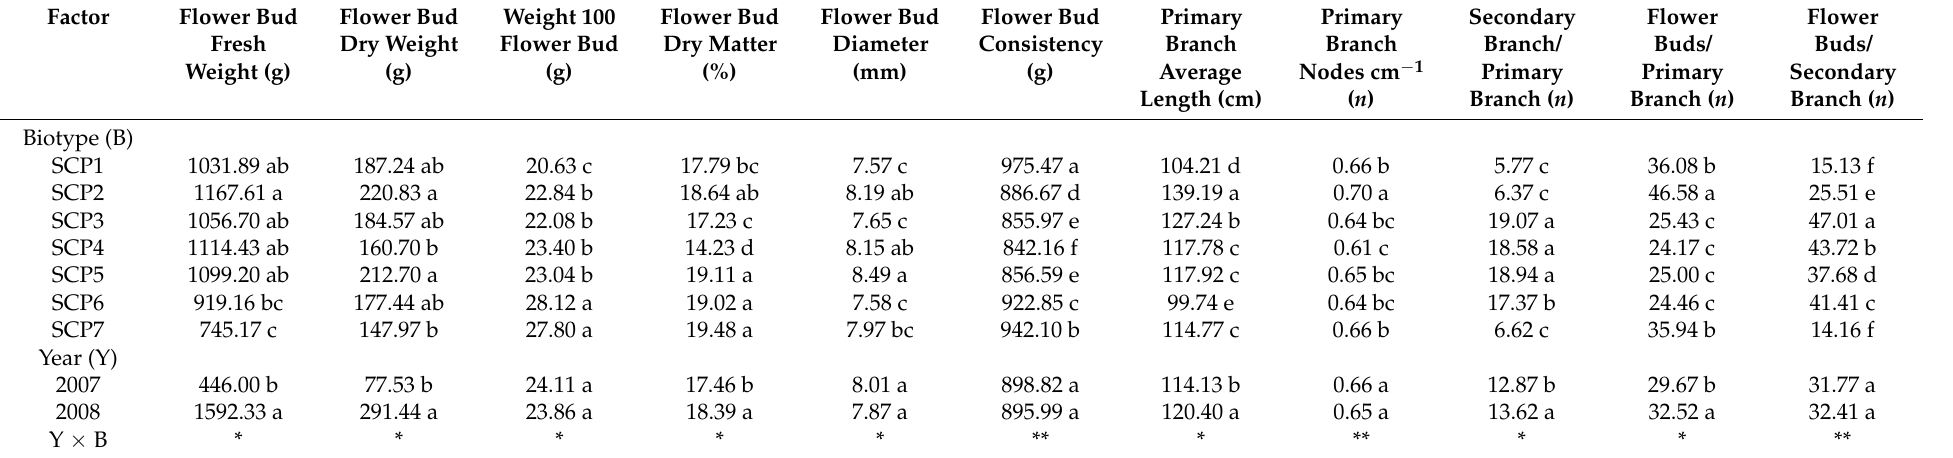
Table 2. Effects of biotype, year and interaction biotype-by-year on biometric and production parameters. Average values are